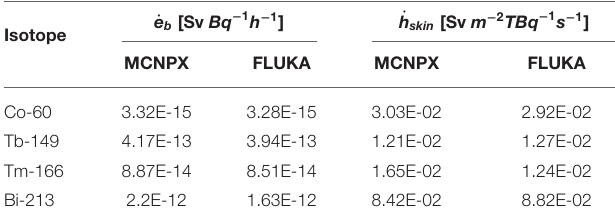
TABLE 6 | Results of the ˙ e b and ˙ h skin dose coefficients from the Monte Carlo method with MCNPX and FLUKA.